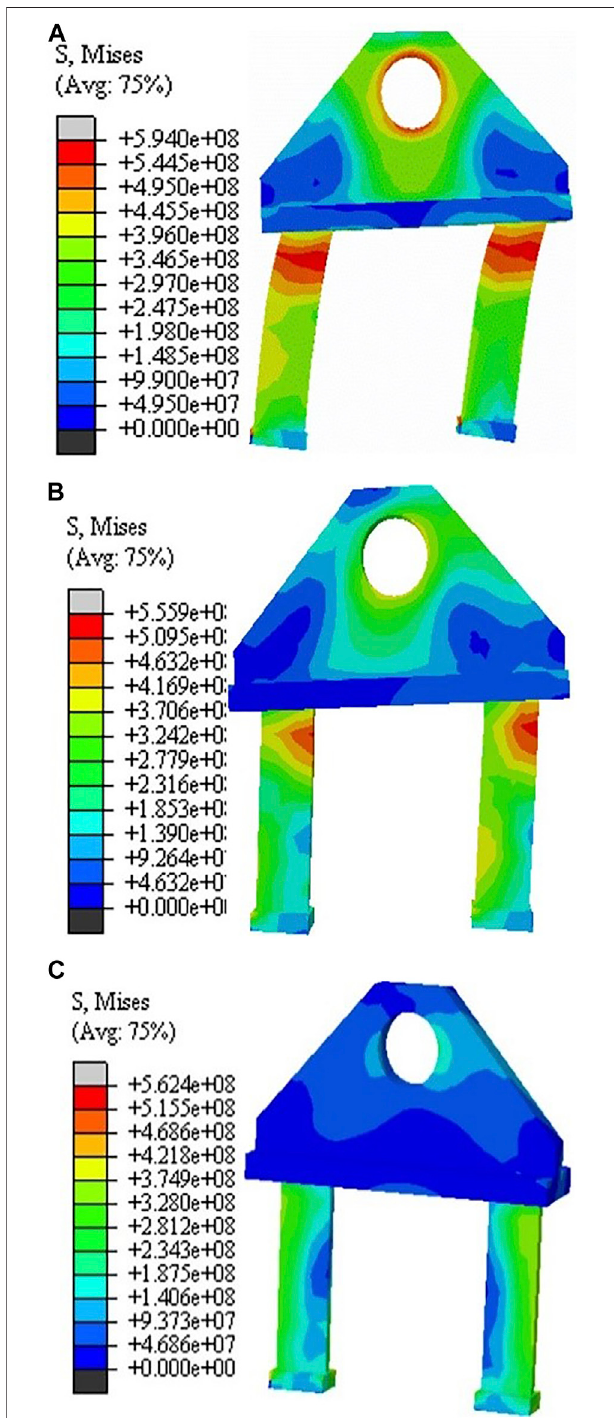
FIGURE 17 | Numerical stress distribution with different tension directions: (A) C30-000 PESC, (B) C30-450 PESC, (C) C30-900 PESC.